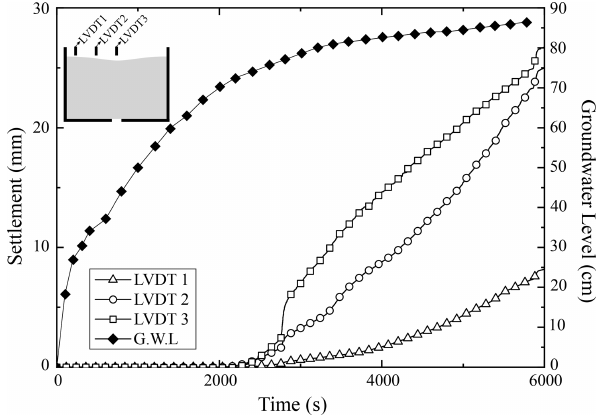
Figure 10. LVDT measurement during the water supply stage (Test